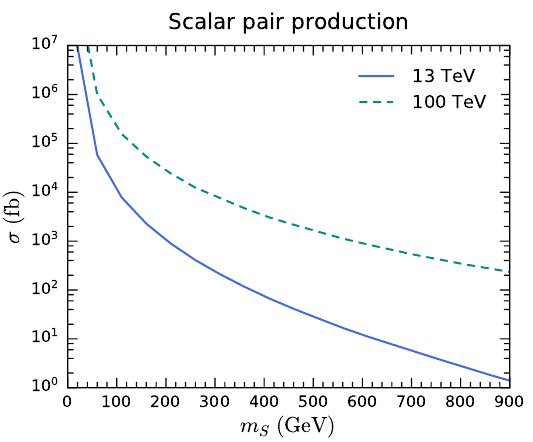
Figure 5 . Production cross sections as functions of m S for pp → S i S j + jets with S i = ( a 0 , φ 0 , S ± √ S ± , S 2 ± , S 2 ± , S 3 ± ) at s = 13 TeV and 100 TeV . The couplings are fixed as λ + = λ − = λ 3 = 0 2 1 2